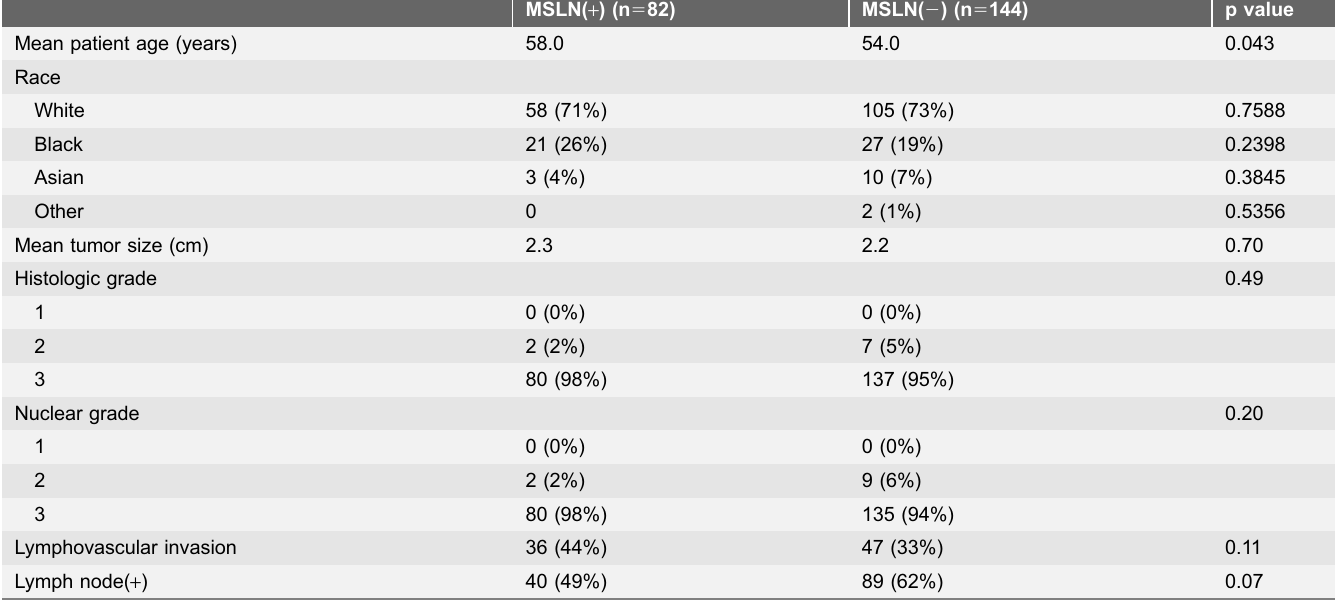
Table 4. MSLN expression and clinicopathological characteristics of TNBC.